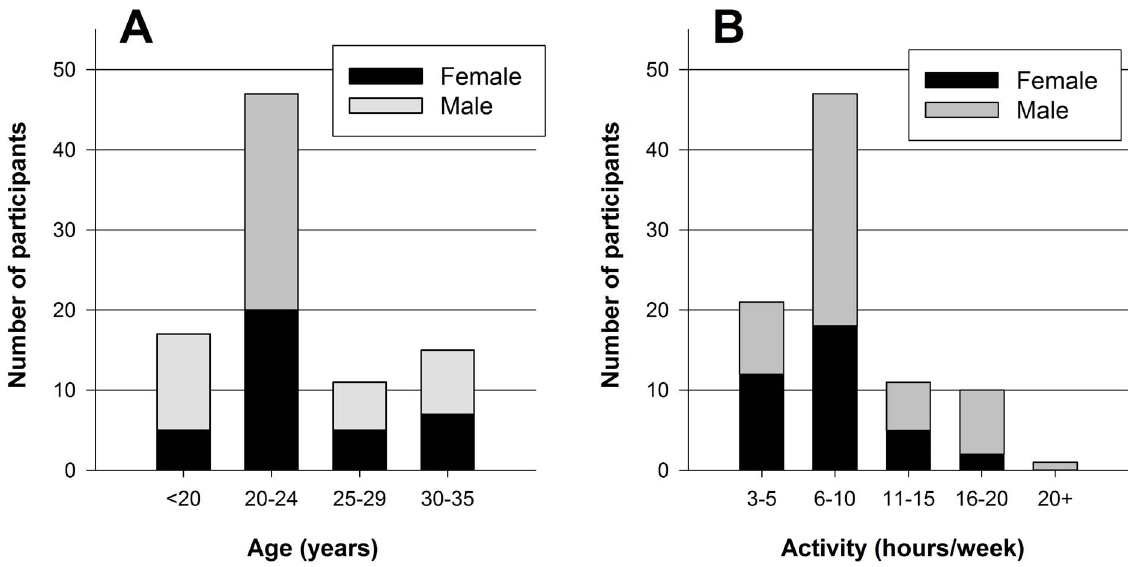
Figure 1. Description of the study participants (N=90) for (A) age group and (B) activity level (hours per week).